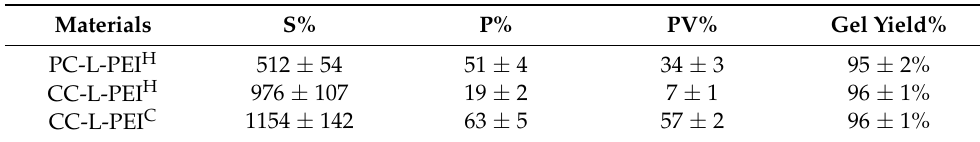
Table 1. Swelling rate (S%), porosity (P%), pore volume (V p ), and gel yield % of physically and chemically crosslinked L-PEI networks. Materials S%